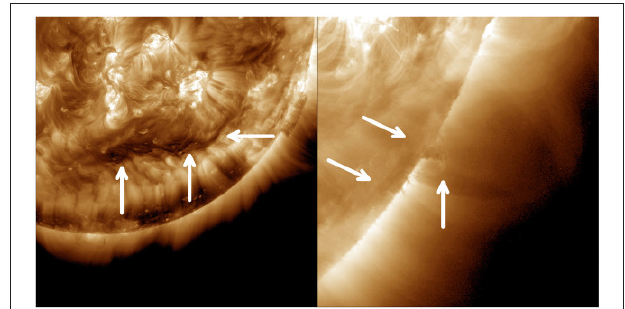
FIGURE 1 | AIA 193 Å observations of the filament. Left : 4 October 2014 at 18:18:06 UT. Right : 9 October 2014 at 18:24:42 UT. The arrows point to the prominence location.